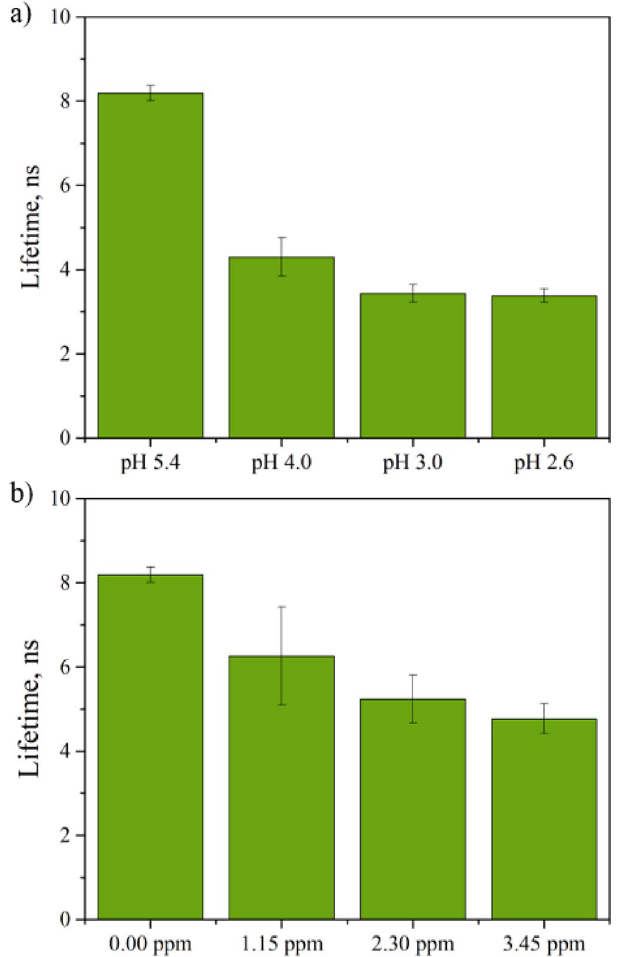
Figure 4. ( a ) Fluorescence band 430 nm average lifetime values at pH 2.6, 3.0, 4.0 and 5.4; ( b ) Fluorescence band 430 nm average lifetime values change with increase in Fe 3+ ion concentration (0–3.5 ppm). Error bars represent ± standard deviation (n =